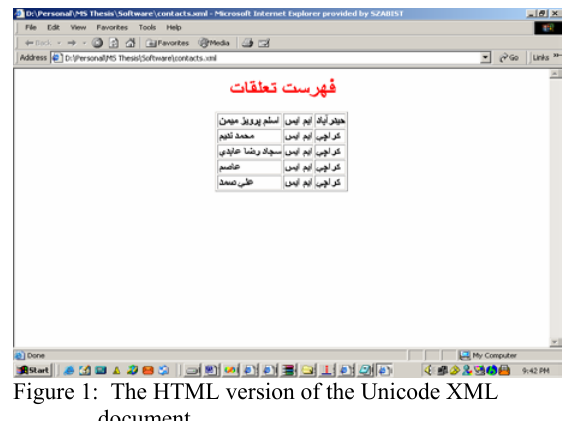
Figure 1: The HTML version of the Unicode XML